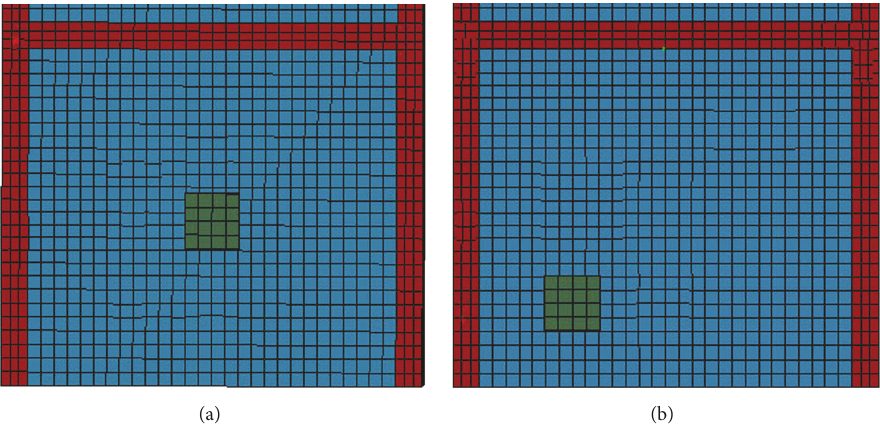
Figure 21: Relative impact positions: (a) model 10 and (b) model 11.